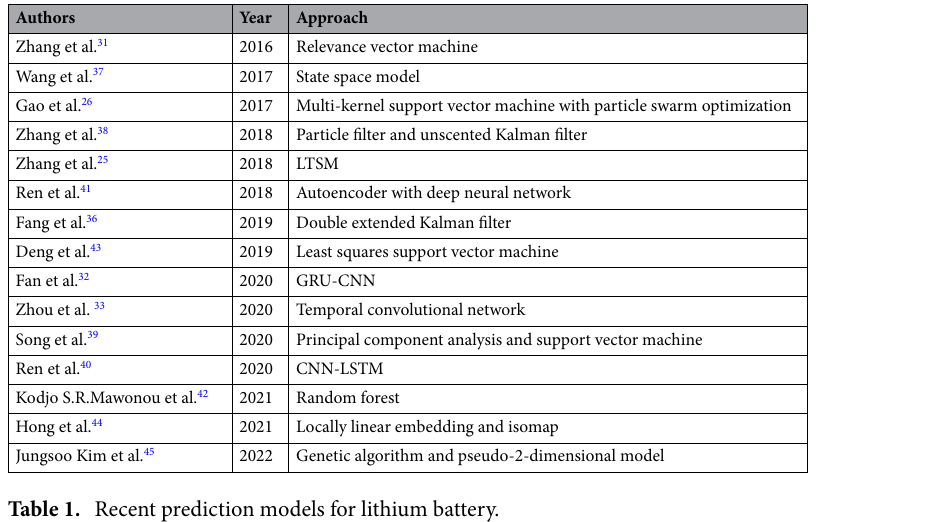
Table 1. Recent prediction models for lithium